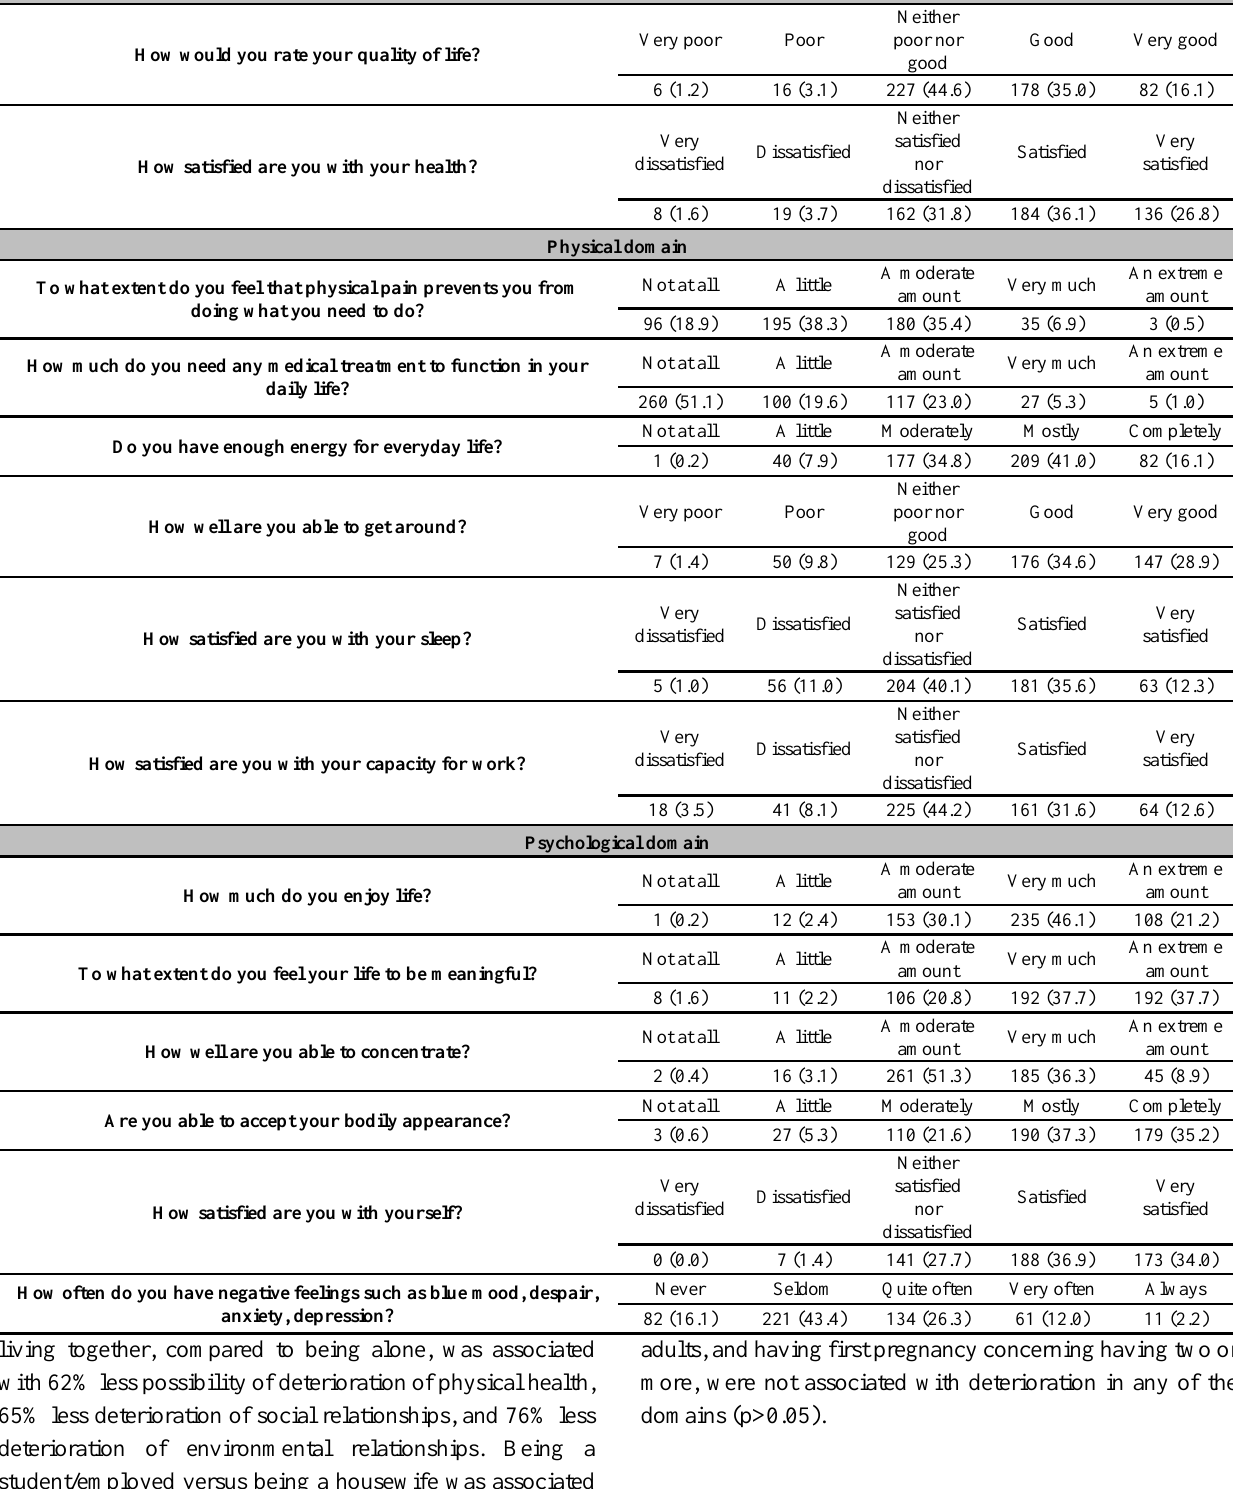
Table 2: WHOQOL-BREF scale. Quality mof life and general health, Physical domain and Psychological domain (n=509, %) Quality of life and general